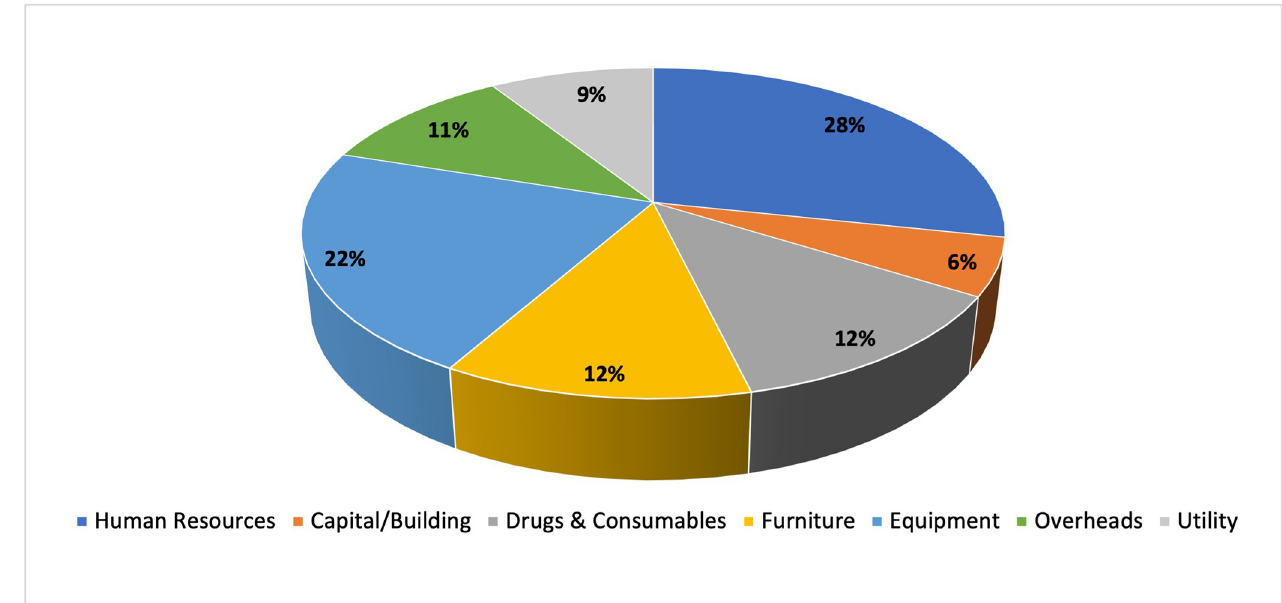
Fig 2. Percentage share of time for each input